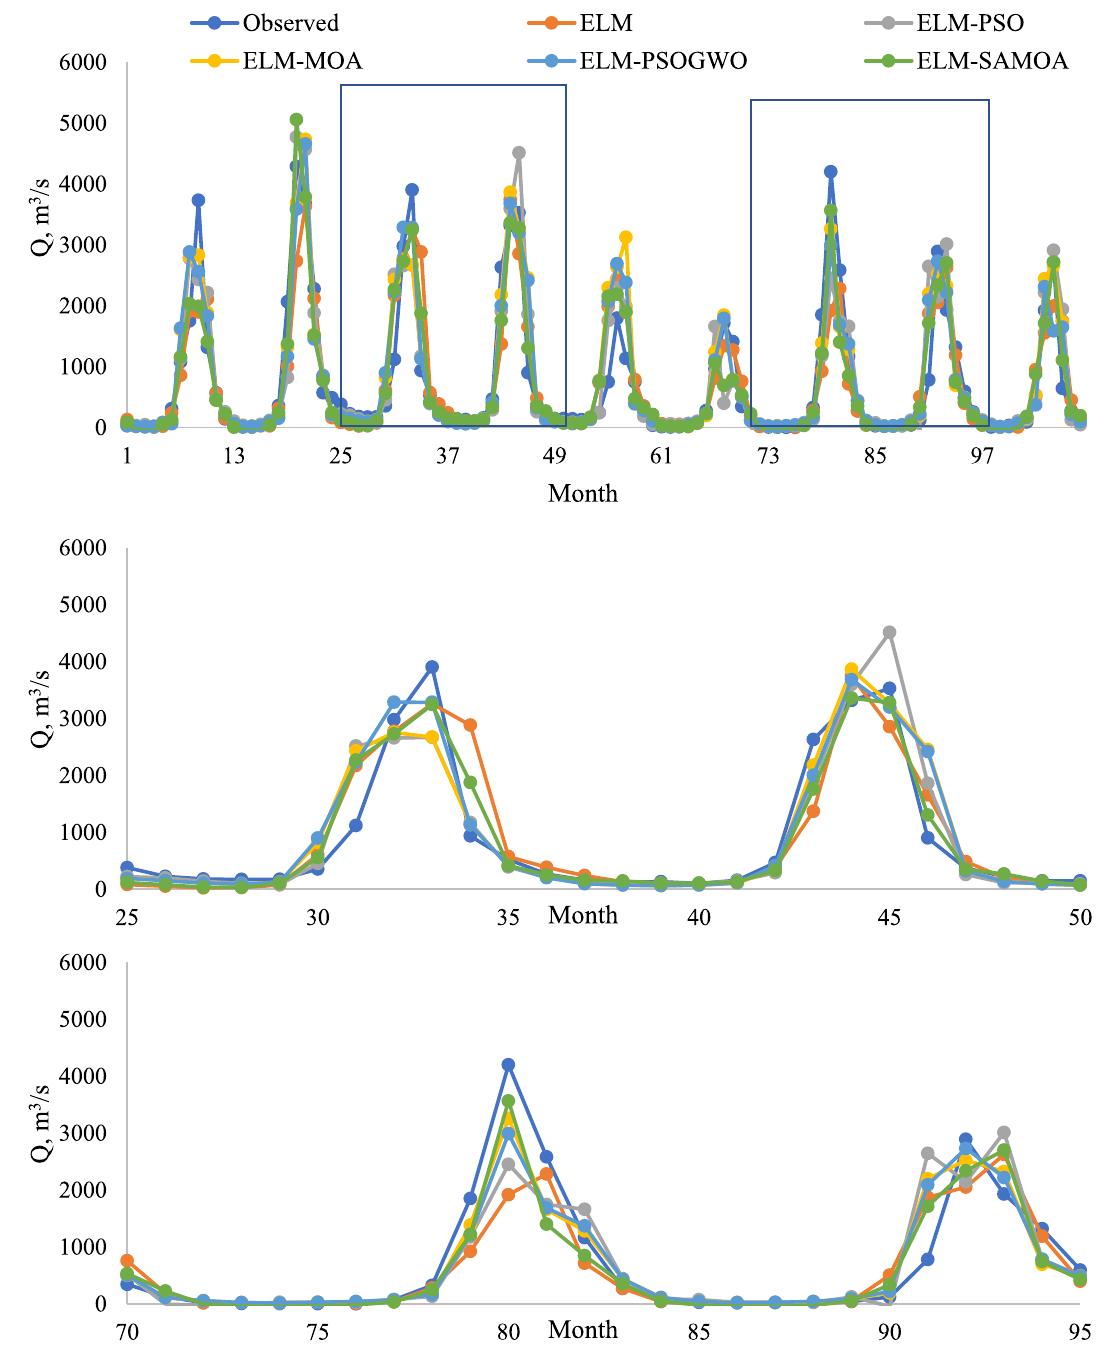
Fig. 6 Time variation graphs of the observed and predicted streamflows by different ELM-based models in the test period of Gorai